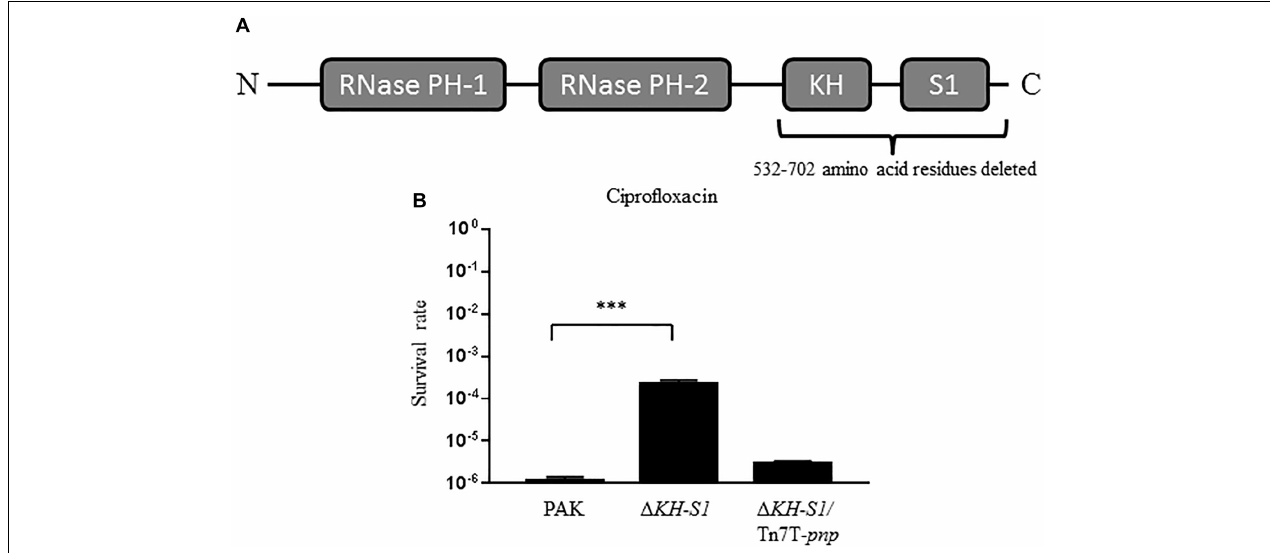
FIGURE 1 | Bacterial survival rates under the treatment of ciprofloxacin. (A) Domains of the PNPase of Pseudomonas aeruginosa . (B) PAK, (cid:49) KH-S1 mutant and the complemented strain ( (cid:49) KH-S1 /Tn7T- pnp ) were grown to an OD 600 of 1.0 at 37 ◦ C and treated with 0.16 µ g/ml ciprofloxacin for 6 h. At indicated time points, the bacterial survival rates were determined by serial dilution and plating assay. ∗∗∗ p < 0.001 by Student’s t -test.